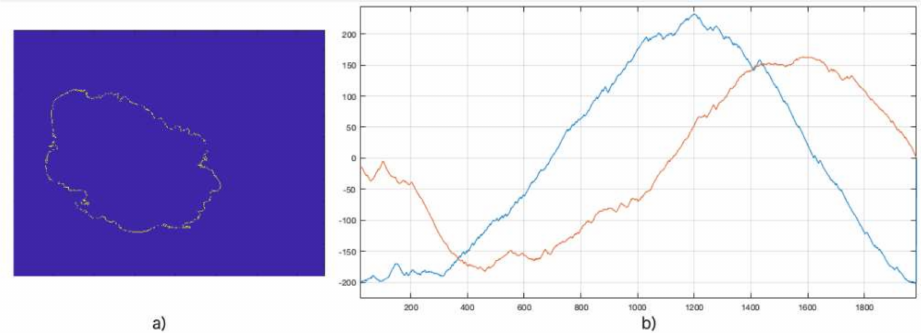
Figure 4. ( a ) Border of the detected lesion area; ( b ) real (blue line) and imaginary parts (red line) of the complex coding of the